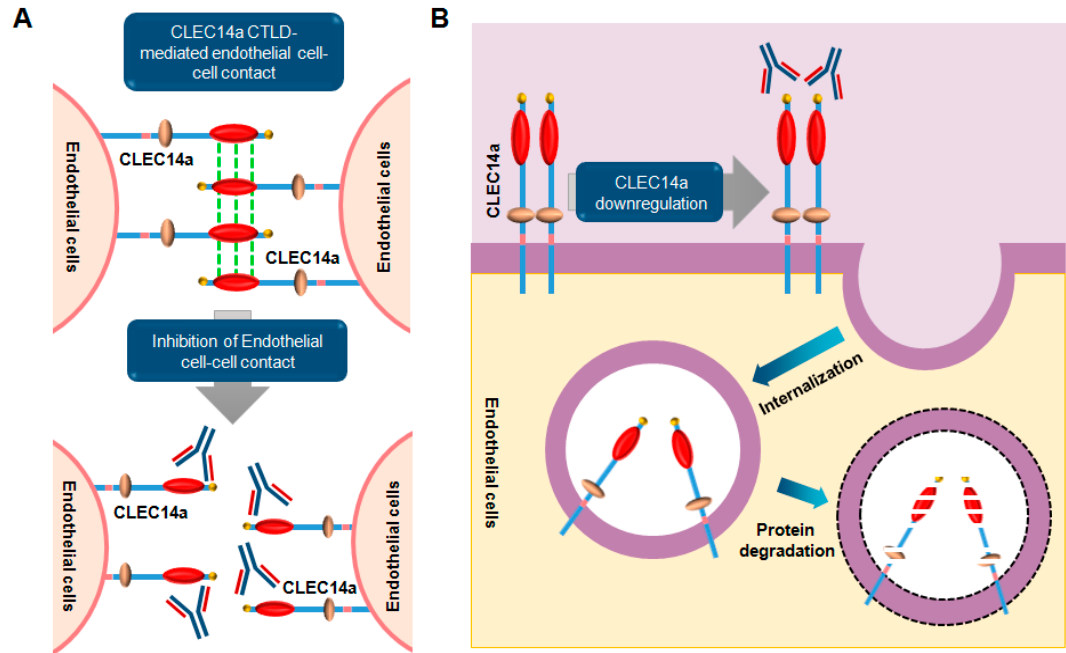
Figure 2. Dual mode of action of a monoclonal antibody targeting the CLEC14a (C-type domain family 14 member) CTLD (C-type lectin-like domain) in cancer. ( A ) In tumor angiogenesis, the CLEC14a CTLD (red) plays a key role in mediating endothelial cell-cell contacts. When a targeting antibody binds to the CTLD of CLEC14a on tumor vessels, endothelial cell-cell contacts are inhibited, resulting in inhibition of tumor angiogenesis. ( B ) Simultaneously, binding of the antibody to CLEC14a on endothelial cells induces internalization of CLEC14a and eventually leads to its downregulation. These molecular mechanisms are important for suppressing CLEC14a-mediated tumor angiogenesis.